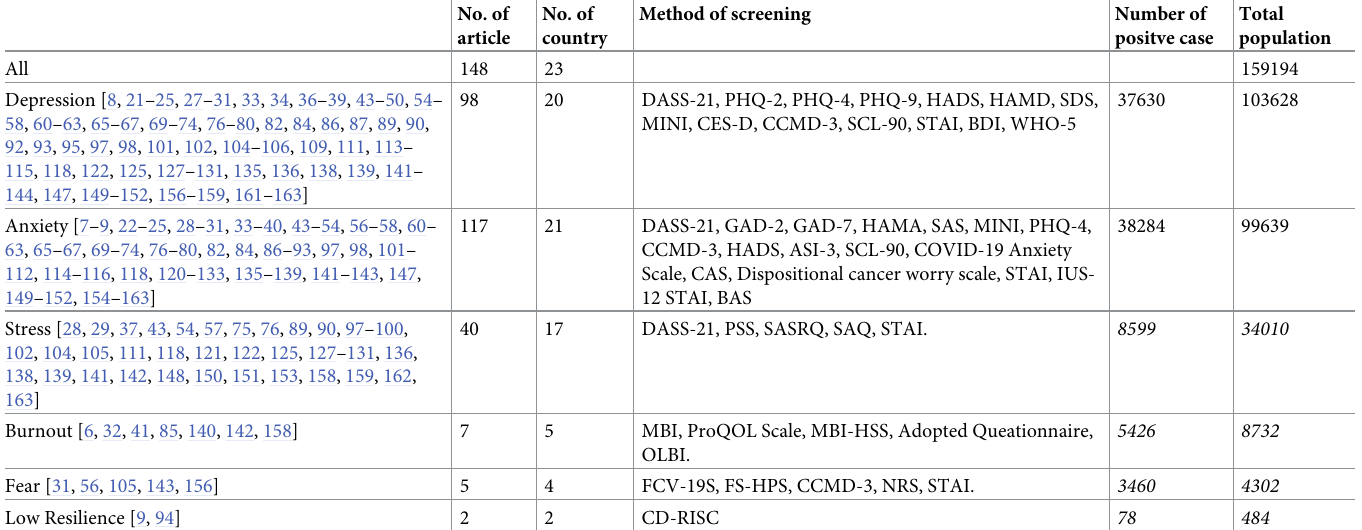
Table 1. Characteristic of 148